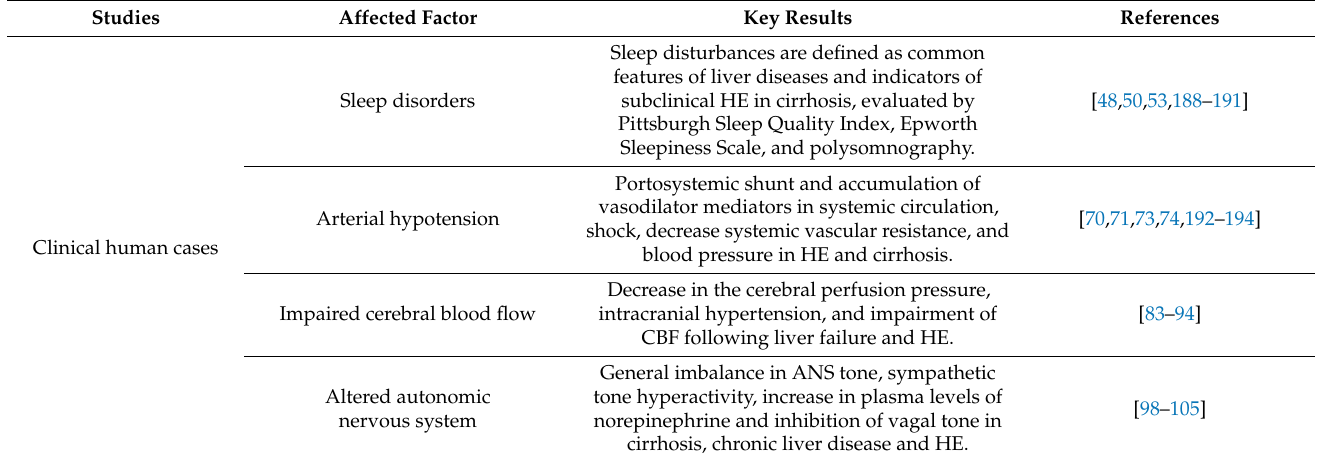
Figure 2. Injured astrocytes differentially express AQP4, impairing the glymphatic system. In several neurological disorders, AQP4 is primarily expressed on the cell body of swollen and reactive astrocytes (A1 phenotype). The AQP4 mislocalization disrupts the flow through the ISF and is responsible for impairment of the glymphatic system, resulting in accumulation of waste metabolites, microglial activation, neuroinflammation, and neuronal toxicity in the brain parenchyma. Similar astrogliosis and mislocalization of AQP4 have been observed in HE. These pathological changes in astrocytes, the main cellular component of the glymphatic pathway, may compromise clearance of ISF in HE. Created with BioRender.com. Table 1. Main effective factors on the normal function of glymphatic system following liver diseases and HE.